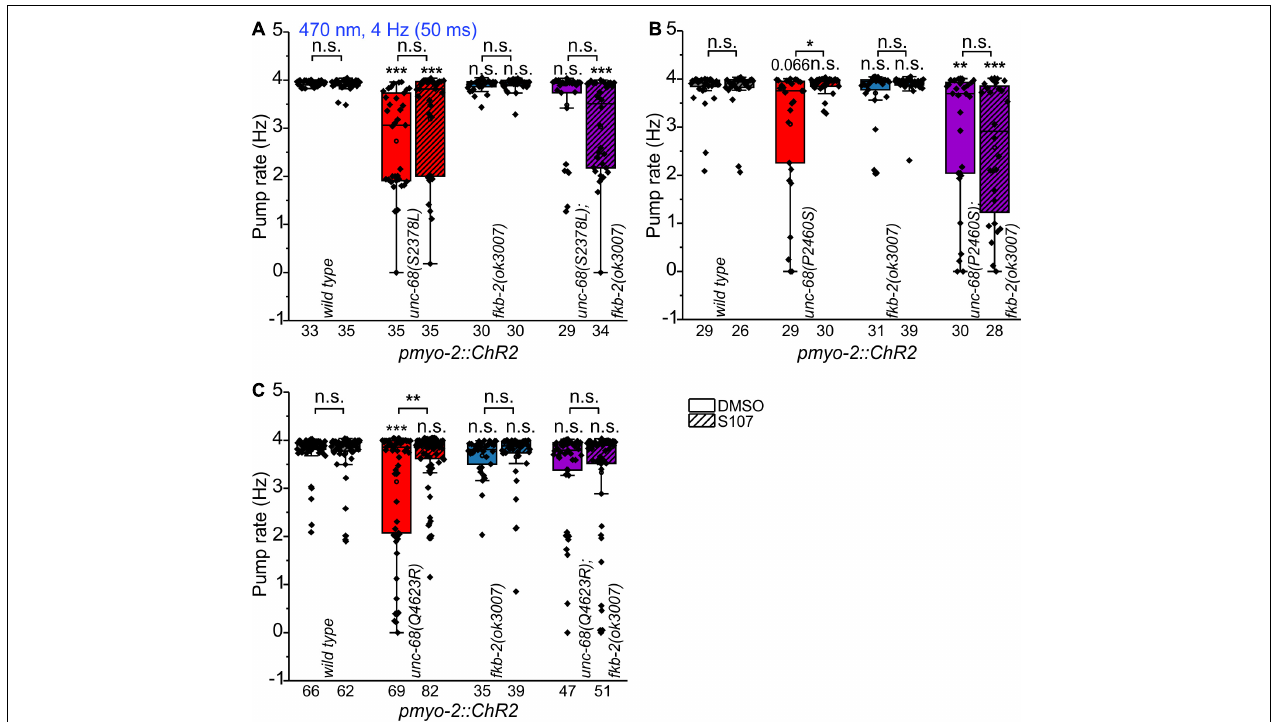
FIGURE 4 | Effect of the benzothiazepine S107. In ScreenChip TM recordings of EPGs under blue light stimulation (4 Hz, 50 ms), the effect of S107 (50 µ M, 30 min pre-incubation, shaded boxes) in comparison to the vehicle DMSO (0.1% in M9 buffer) on pump rate of UNC-68 mutants S2378L (A) , P2460S (B) and Q4623R (C) was determined. Alleles have been crossed with a fkb-2 deletion [ fkb-2(ok3007 ), violet boxes] to check for drug-induced UNC-68 stabilization via FKB-2. S107 rescues UNC-68 function of Q4623R and P2460S only in FKB-2 wt background. Box plots include mean (open circle) and median (line). Significance levels (asterisks), referring to respective controls (wild type, either with or without S107), are located above the corresponding boxes. Comparison of each strain with and without S107 treatment is indicated above the line pointing on the respective boxes. N-numbers as indicated. One-way ANOVA with the Bonferroni post-hoc test was performed: n.s., not significant, * P ≤ 0.05, ** P ≤ 0.01, and *** P ≤